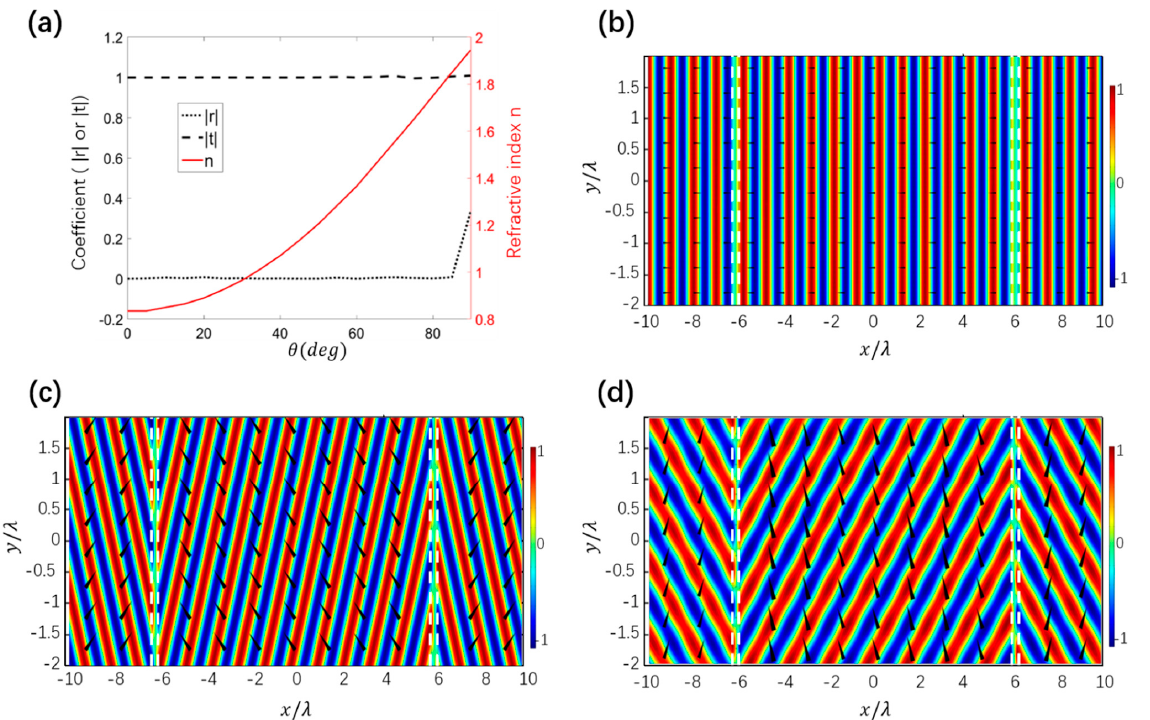
Figure 6. ( a ) The absolute value of reflection | r | , transmission | t | , and the refractive index | n | for the co-existence of CPA and Laser mode as a function of the incident angle θ . ( b – d ) The pressure field distribution at incident angles of θ = 0 0 , θ = 30 0 and θ = 55 0 ,